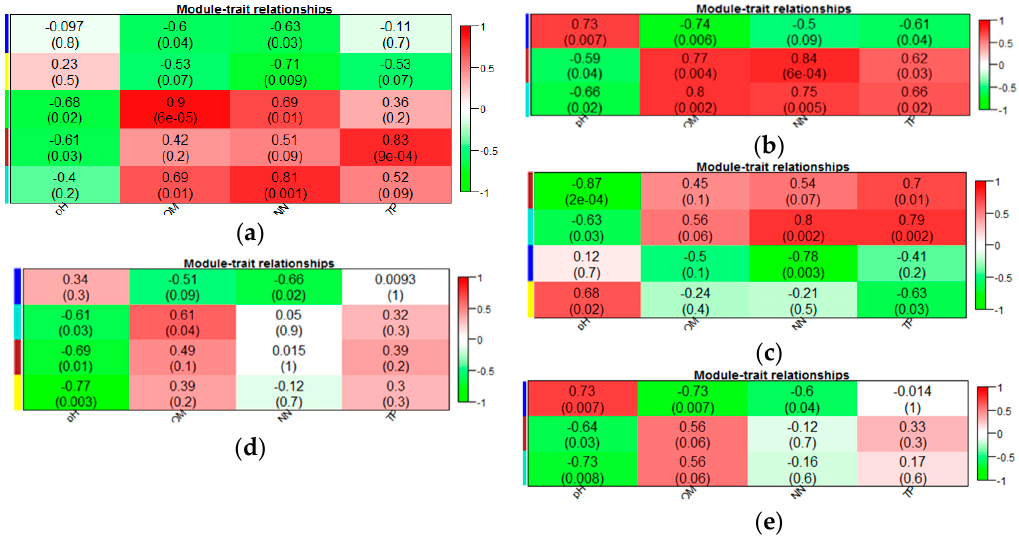
Figure 8. Correlations between the signal intensity of a module and each soil characteristic for the five networks: ( a ) network C; ( b ) network L; ( c ) network M; ( d ) network H; ( e ) network E.